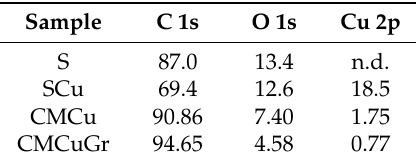
Table 2. Concentration (%) of elements on the surface of the catalysts determined by X-ray photoelectron spectroscopy